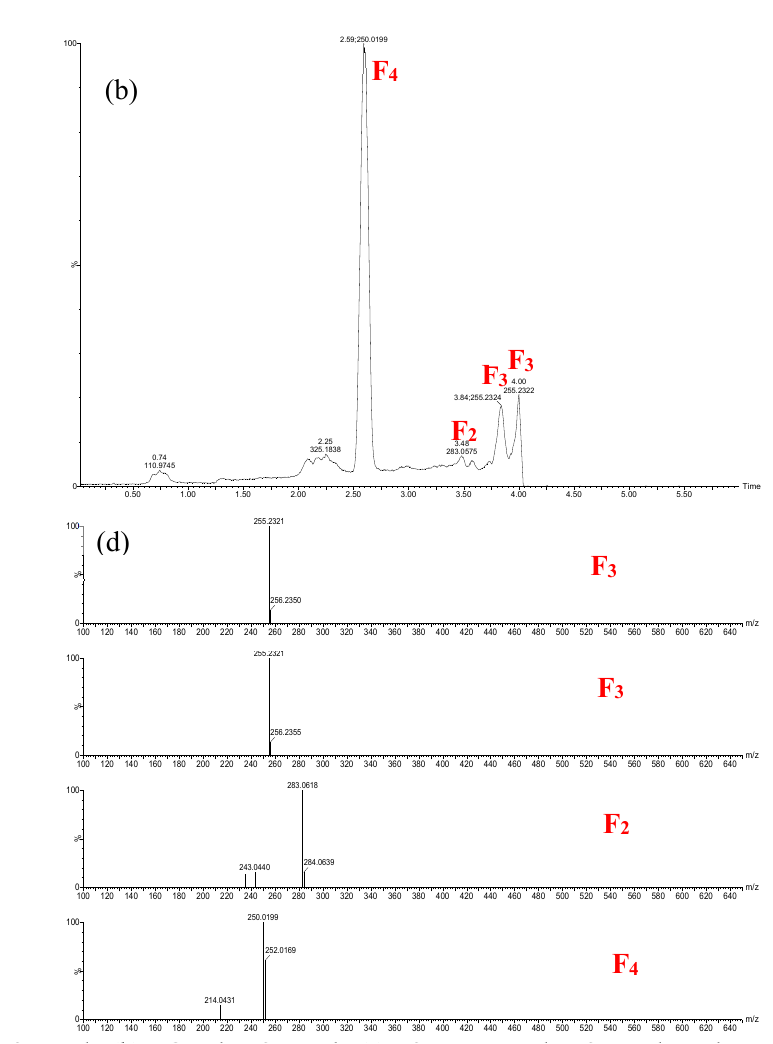
Figure 5. HPLC–MS chromatographic patterns of degradation products. ( a ) TIC in the ESI+ mode, ( b ) TIC in the ESI− mode, ( c ) MS patterns in the ESI+ mode, and ( d ) MS patterns in the ESI − mode under a pH of 5 for a reaction time of 24 h with an initial MnO 2 loading of 200 mg /